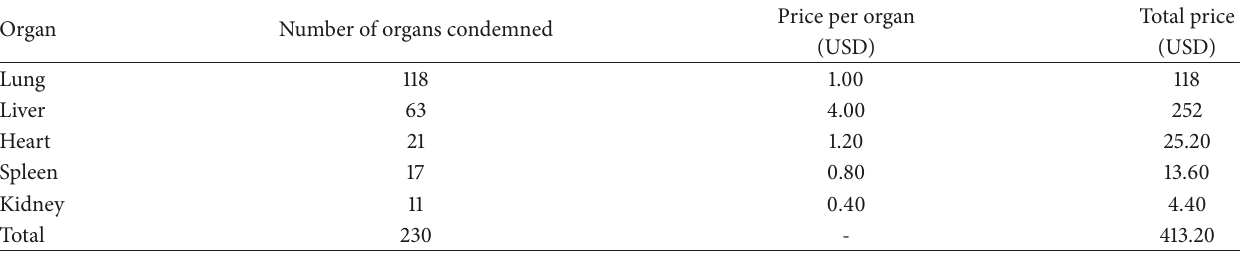
Table 1: Direct economic losses associated with hydatidosis from inspected sample cattle slaughtered at Hawassa municipal abattoir (N=400).